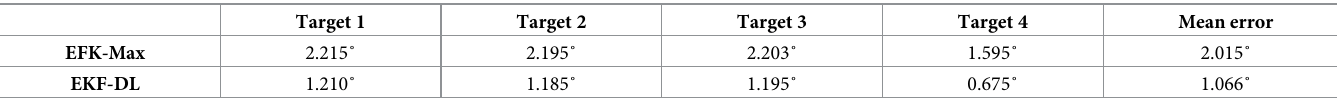
Table 1. Comparison of tracking azimuth